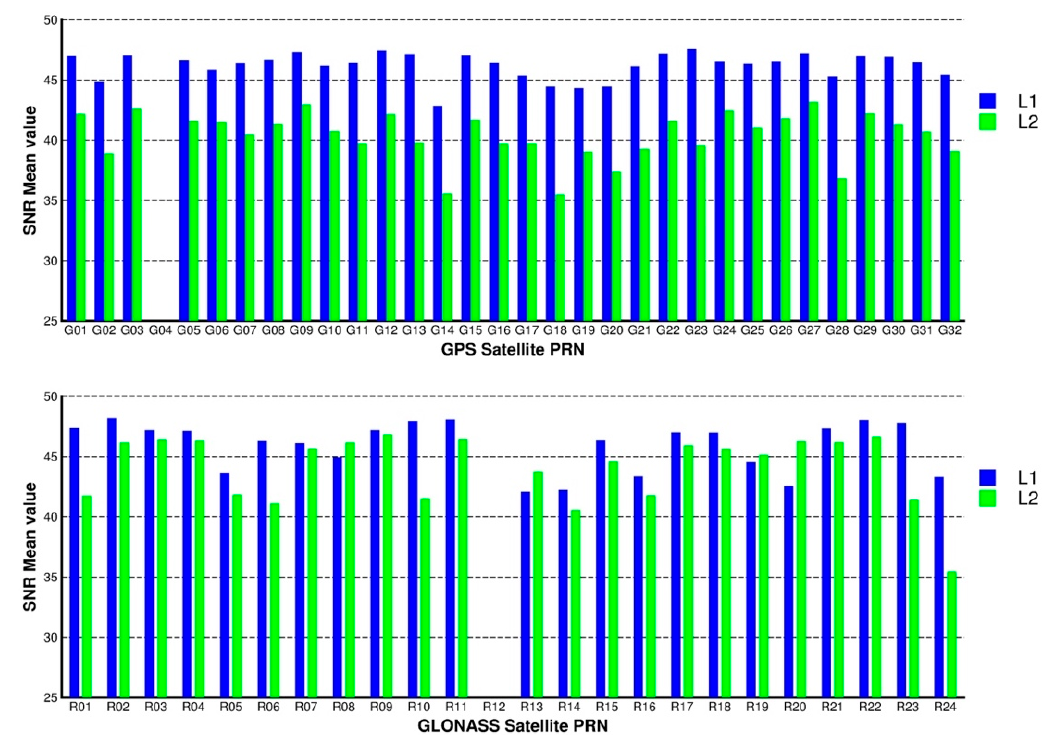
Figure 4. Mean value of GPS and GLONASS SNR measurements in site SHM5 for 22 January 2017 (DOY = 22).